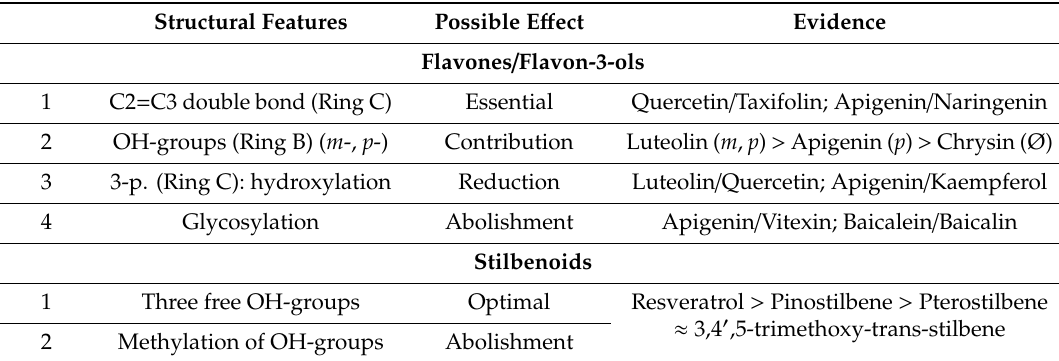
Table 2. Summary of the semi-quantitative structure-activity relationships of flavones / flavonols and stilbenoids regarding pAkt inhibition.